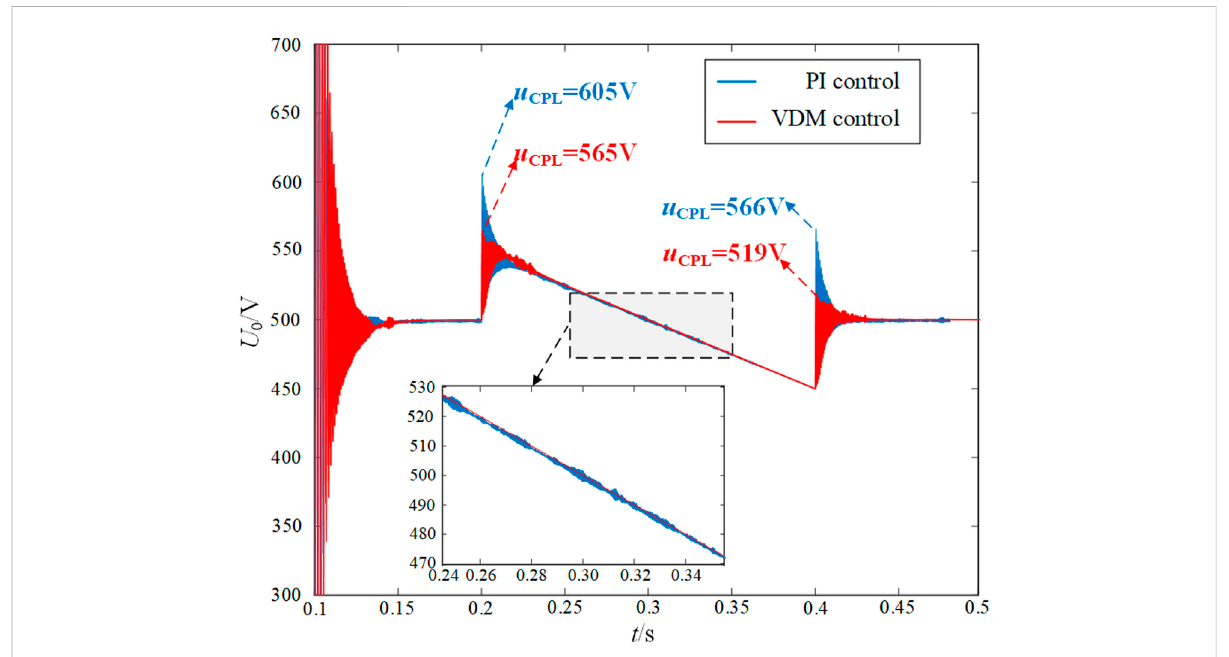
FIGURE 11 Comparison diagram of CPL voltage under CPL load linear change condition.